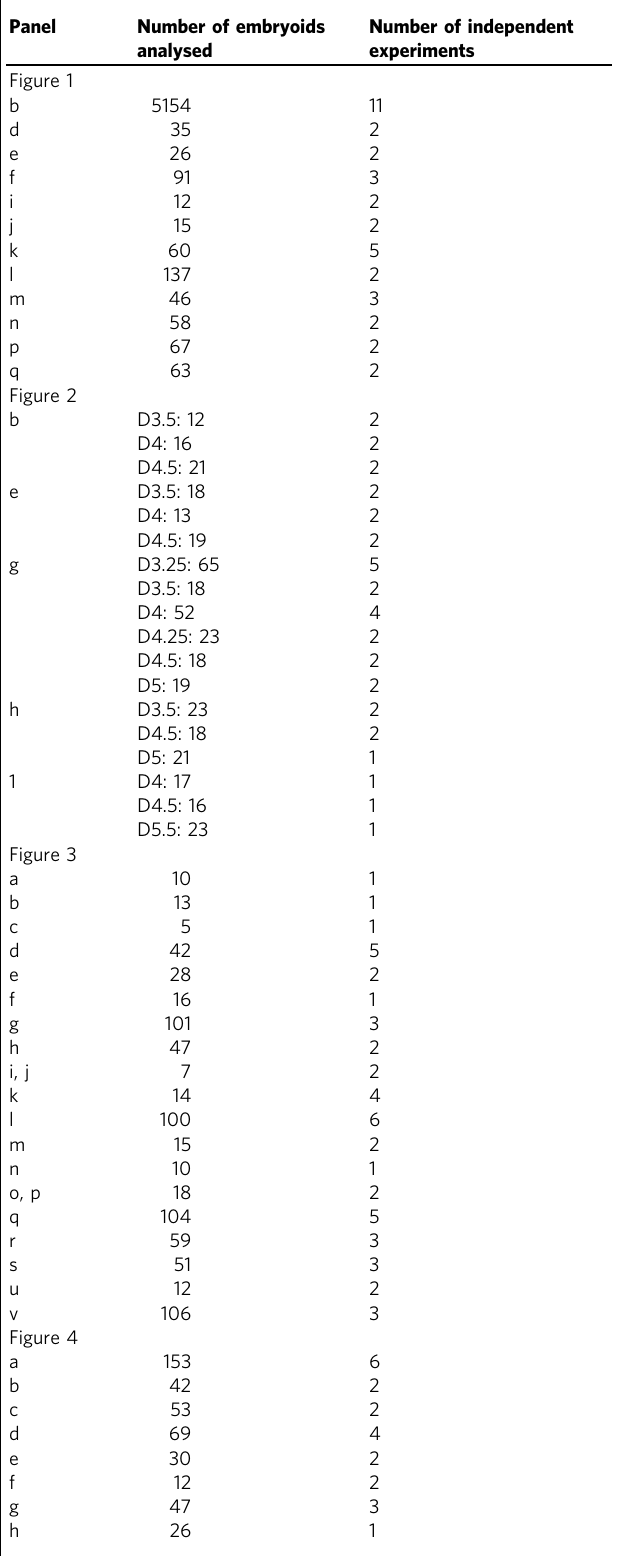
Number of embryoids analysed